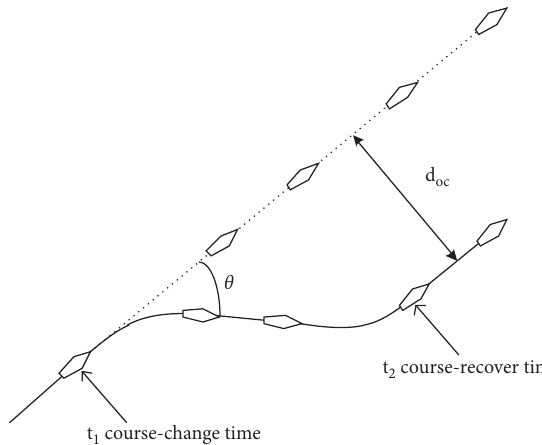
Figure 3: A sample of collision avoidance decision.